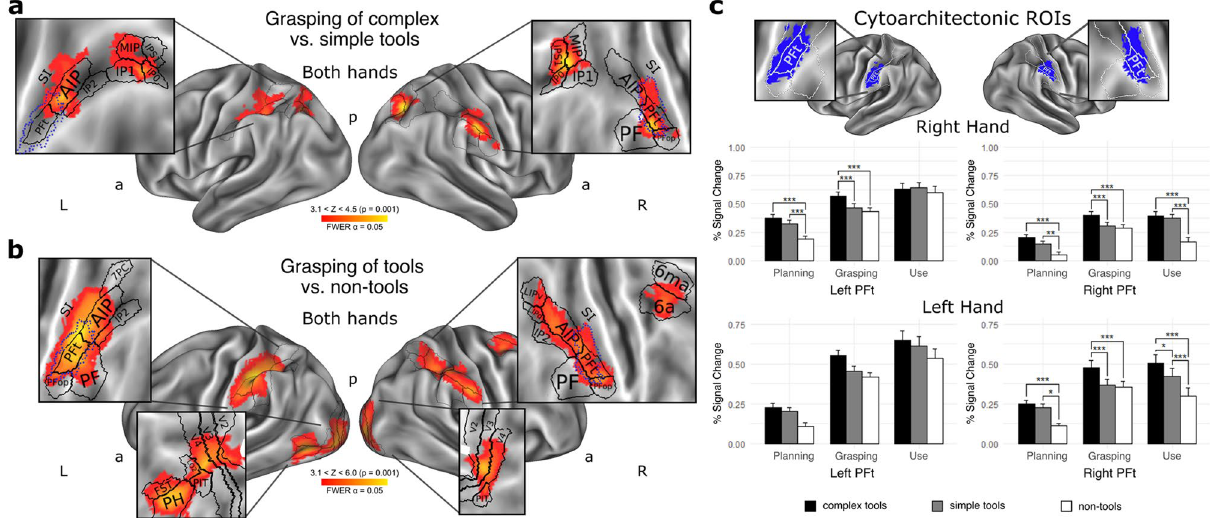
Figure 2. Neural correlates of motor-to-mechanical transformations. ( a, b ) Task-related contrasts revealing significantly different clusters of voxels, with each voxel thresholded at Z > 3.1, and a (corrected) cluster significance threshold of p = 0.05 (controlling for family-wise error rate, FWER), during the transition from grasping to using of ( a ) complex tools as compared to simple tools, and ( b ) both simple and complex tools, as compared to control objects, i.e., sticks and twigs, regardless of the hand. Insets with flattened brain surfaces depict significantly active areas in more detail (by the use of parcels from an atlas 23 ). Blue dots in insets indicate smoothed borders of the Region of Interest (ROI) shown in ( c ). ( c ) ROI analyses in the independently defined tenuicortical supramarginal area (PFt) of the inferior parietal lobule (based on Juelich probabilistic cytoarchitectonic maps, thresholded at 50th% of their maximum probability 21 ) and visualized in top row on the right. Middle row: graphical depiction of the results of a significant interaction of phase (Planning, Grasping, Using) and object category (Complex tools, Simple tools, Non-tools) in the 3 × 3 repeated-measures analysis of variance (rmANOVA) for the left PFt (F 2.447, 46.496 = 5.999, P = 0.0028, ηp 2 = 0.240, 1-β = 0.906) and right PFt (F 4, 7 6 = 6.695, P = 0.0001, ηp 2 = 0.261, 1-β = 0.990) conducted on neural signals associated with tasks performed with the dominant right hand. Bottom row: this same interaction observed in the left (F 4, 7 6 = 1.645, P = 0.172) and right PFt (F 4, 7 6 = 4.310, P = 0.0034, ηp 2 = 0.185, 1-β = 0.915) for tasks performed with the non-dominant left hand. Asterisks indicate significant differences with p-values of ≤ 0.05 (*), 0.01 (**), or 0.001 (***) in post hoc Bonferroni corrected